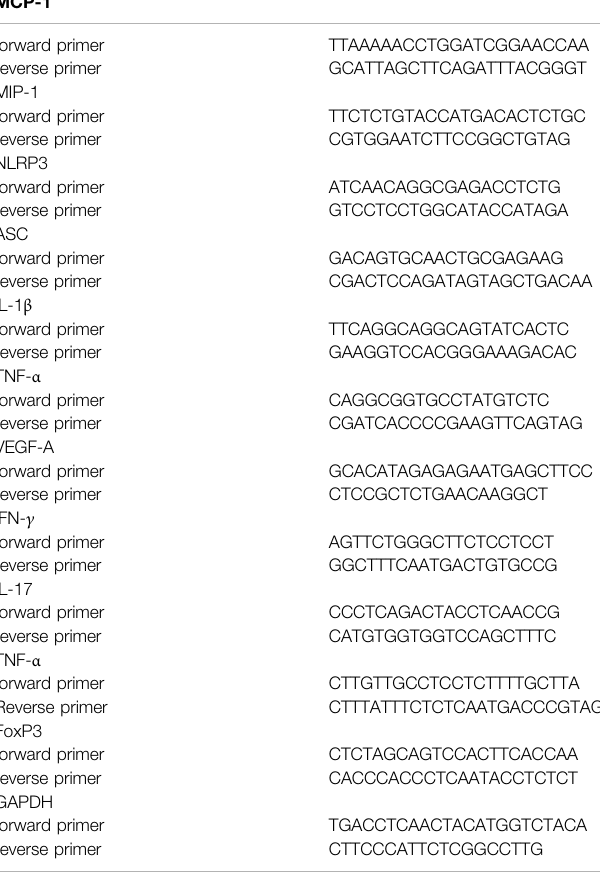
TABLE 1 | Primer sequences of mouse genes for real-time